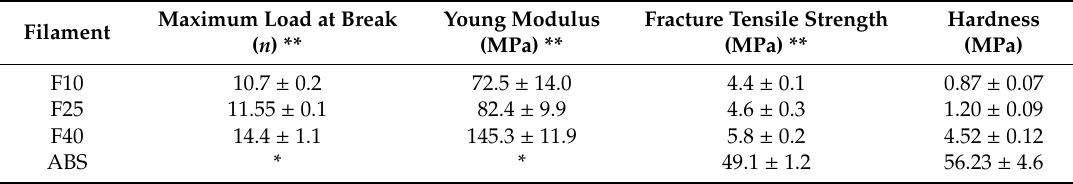
Table 2. Properties of the